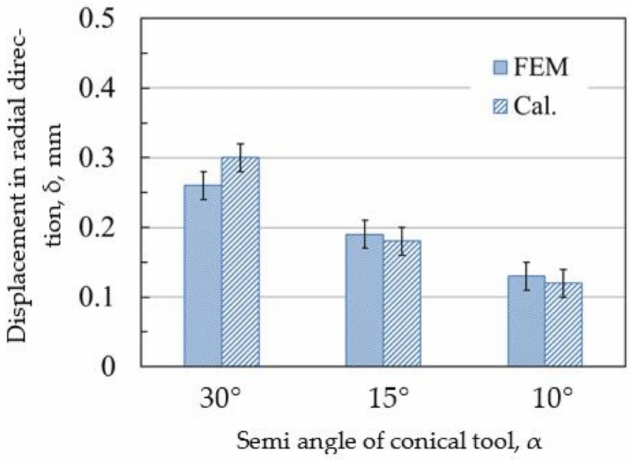
Figure 8. Comparison between calculated δ values with Equation (20) and the ones obtained with the